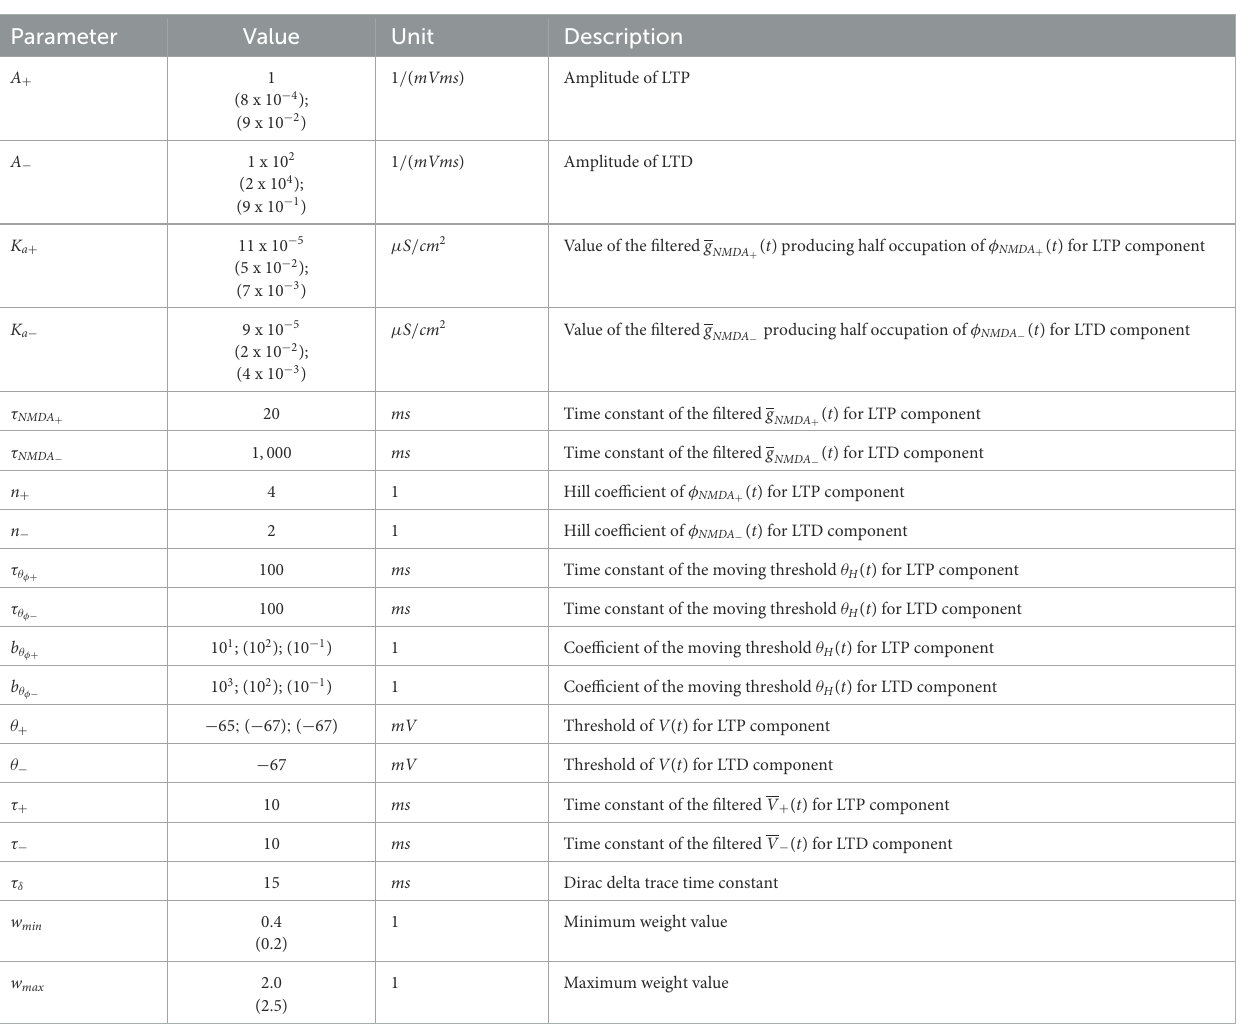
TABLE 1 Parameters of synaptic plasticity model.